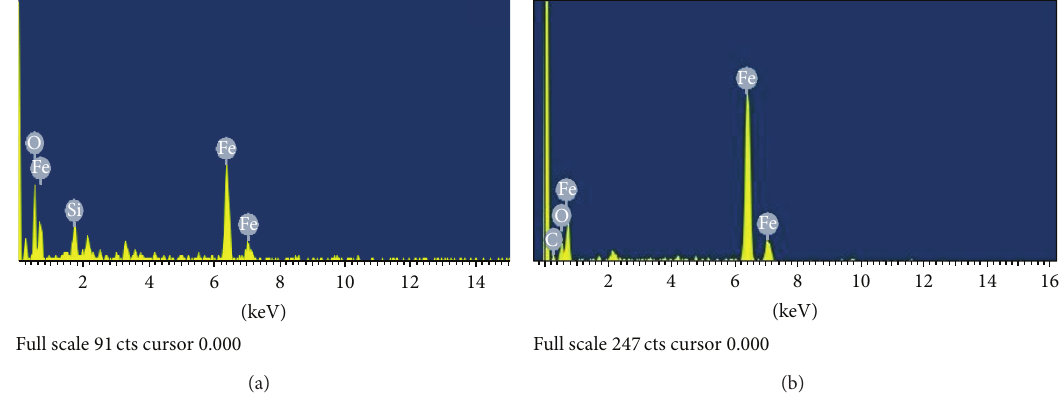
Figure 2: The surface elemental composition of freshly prepared NZVI@SiO 2 -NH 2 and NZVI: (a) EDS image of the NZVI@SiO 2 -NH 2 and (b) EDS image of the